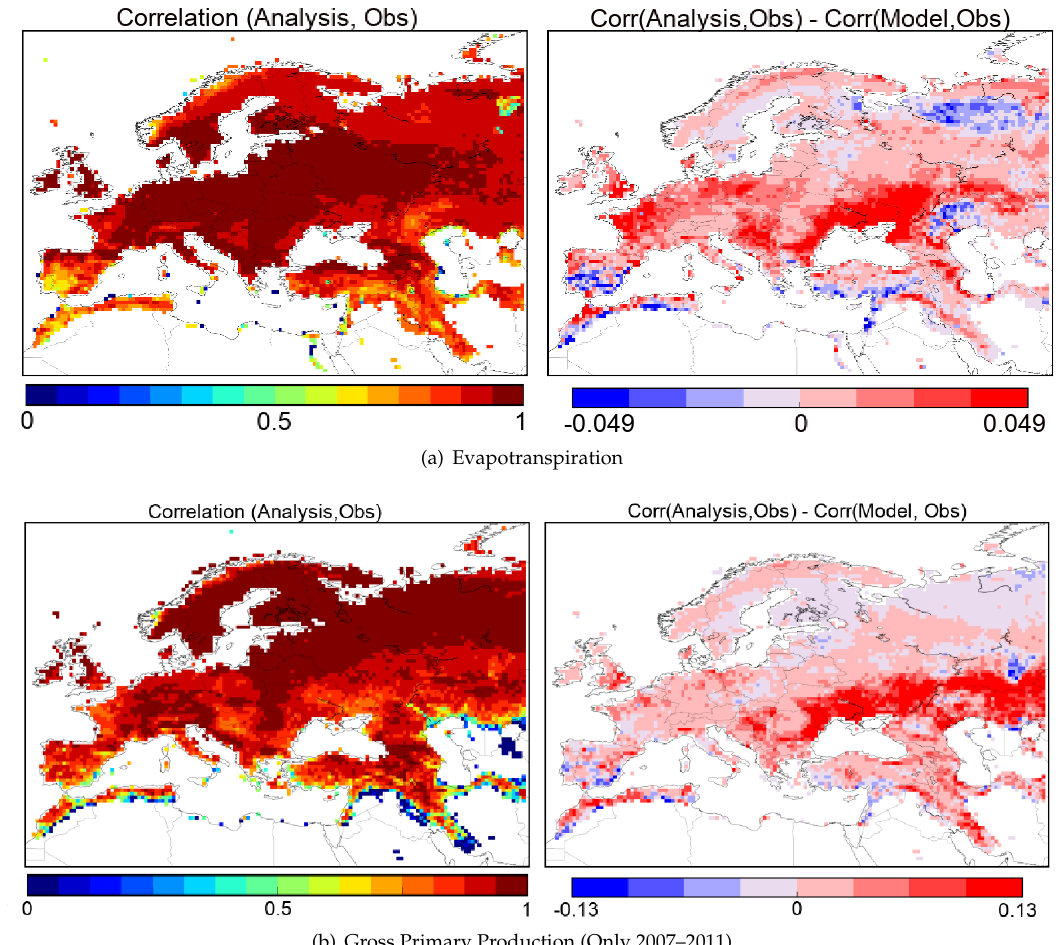
Figure 6. Correlation maps between the analysis and the observations (left column) and changes in correlation triggered by the assimilation (right column, where red means an improvement after assimilation) for the whole 2007–2015 period for: ( a ) E and ( b )